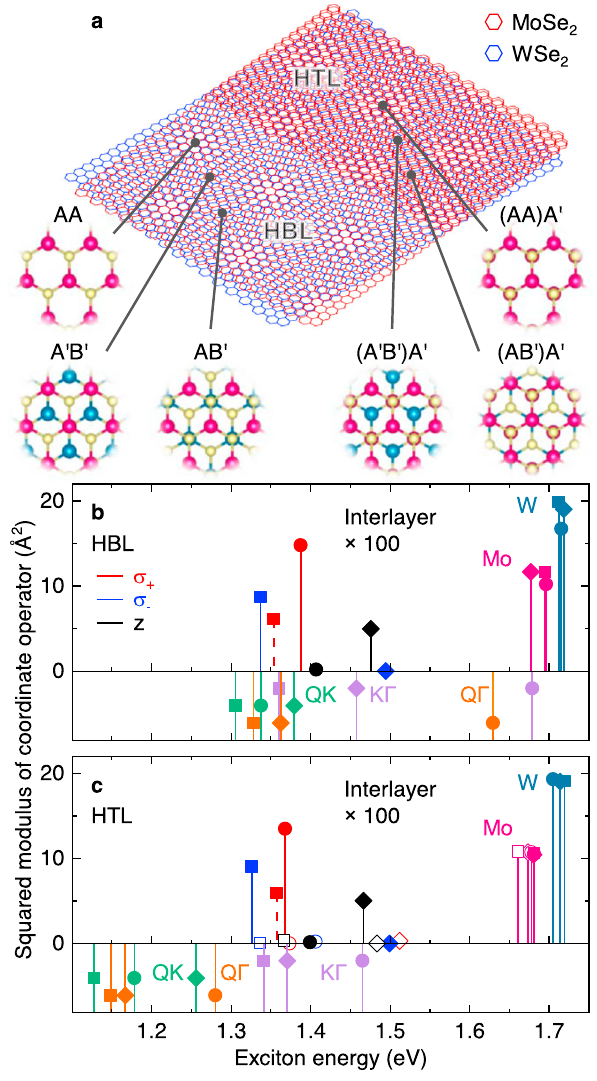
Fig. 2 Theory of excitons in high-symmetry stackings of MoSe 2 -WSe 2 heterobilayer and heterotrilayer. a Schematics of twisted HBL and HTL MoSe 2 -WSe 2 with different high-symmetry stackings. b , c Energy and squared sum of coordinate operator (multiplied by 100 below 1.55 eV) for intralayer and interlayer excitons in HBL and HTL, respectively, calculated for three different stackings. Filled squares, circles, and diamonds denote A'B', AA, and AB', and (A'B')A', (AA)A', and (AB')A' stackings in HBL and HTL, respectively. Empty symbols indicate corresponding HTL excitons with electrons residing in the topmost MoSe 2 layer. For zero-momentum KK interlayer excitons (top panels) we indicate the spin con fi guration by solid and dashed lines for spin-like and spin-unlike states (corresponding to spin-singlet and spin-triplet excitons), and the polarization of the respective exciton emission by red ( σ + ), blue ( σ − ), and black (in-plane z ) colors. The bottom panels show the energy of fi nite-momentum interlayer excitons in QK (green), Q Γ (orange), and K Γ (violet) con fi gurations without direct radiative